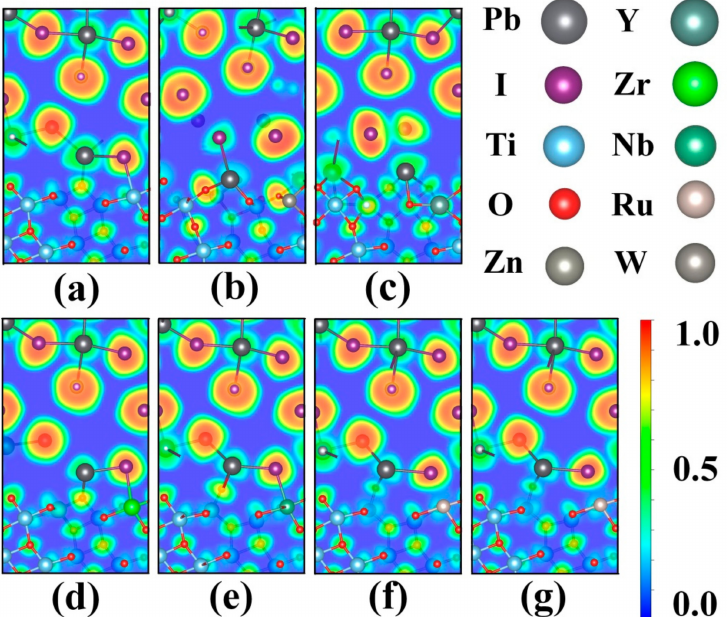
Figure 5. ELF of the optimized CH 3 NH 3 PbI 3 / TiO 2 interfaces at (010) plane: ( a ) pristine, ( b ) Zn-substituted,